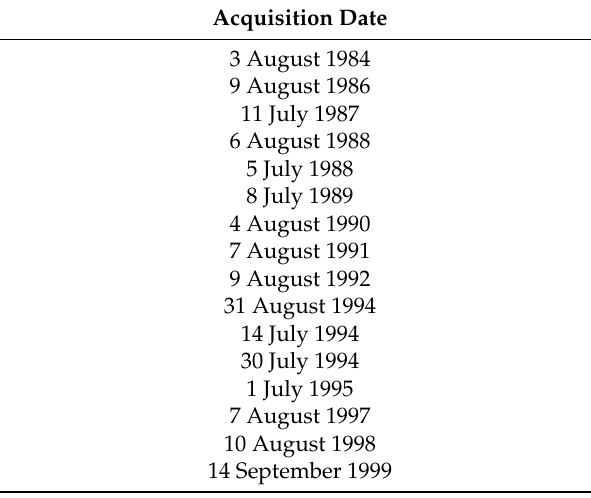
Table 1. List of Landsat TM5 images (path 192, row